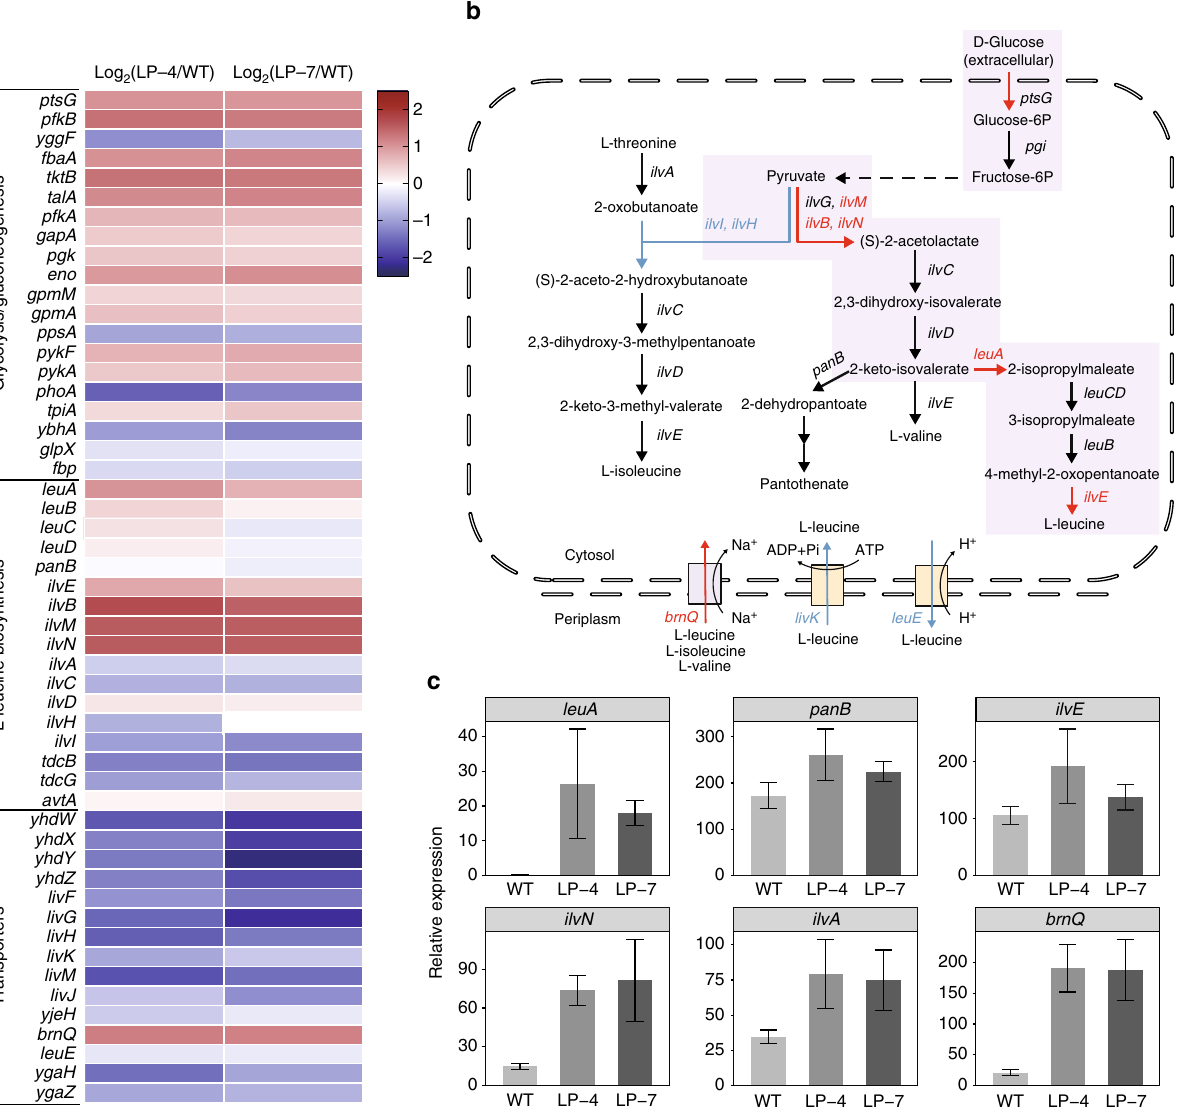
Fig. 6 Transcription pro fi les of BCAA biosynthetic pathways in LP-4 and LP-7. a Transcriptome analysis of LP-4, LP-7, and the wild-type strains. Positive values (red) represent upregulated genes and negative values (blue) represent downregulated genes, which were calculated by the RPKM of LP-4 and LP-7 divided by that of the wild-type strain (in log 2 ). The top, middle, and bottom panels contain genes in glycolysis, L -leucine biosynthesis and BCAA transportations, respectively. b The BCAA biosynthetic pathways in E. coli , red and blue arrows indicate the up- and downregulated genes, respectively. c qRT-PCR veri fi cation of the genes related to L -leucine biosynthesis and transportation. Values and error bars represent the mean and the s.d. ( n =